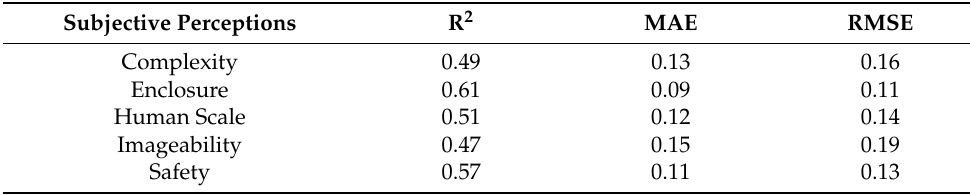
Table 1. Prediction performance using RF algorithm.